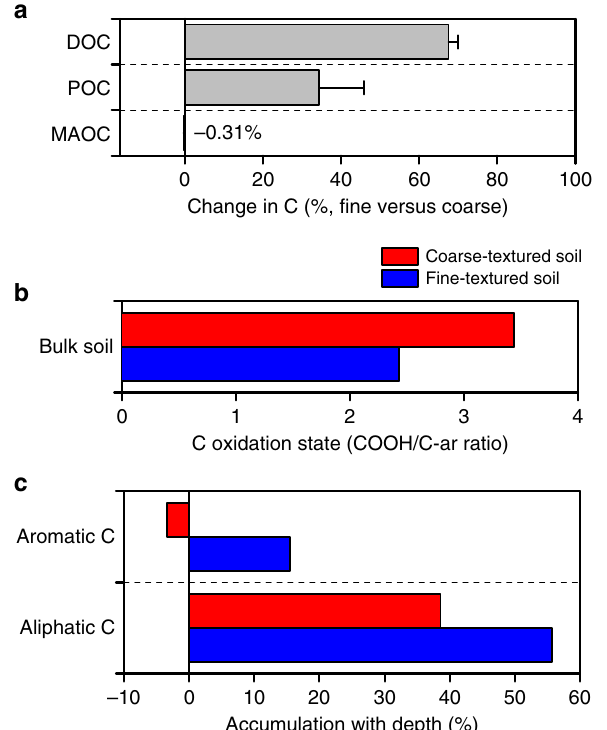
Fig. 5 Impact of soil particle size distribution, and the associated variations in anaerobic soil volume, on carbon bioavailability and chemistry.